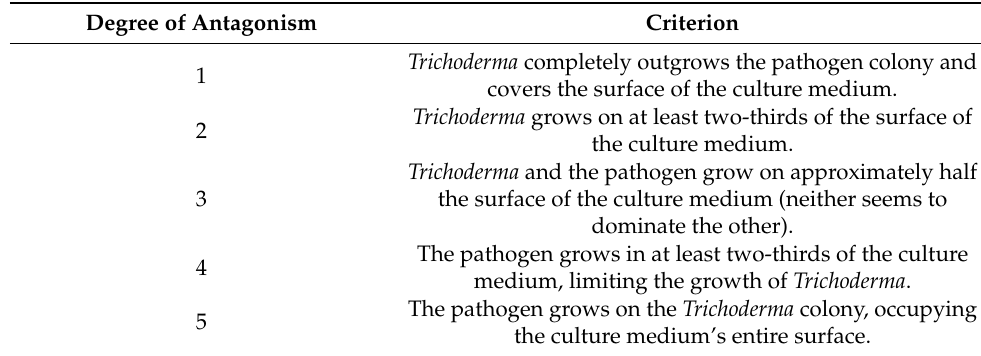
Table 1. Antagonism degree scale according to Bell’s scale (1982)